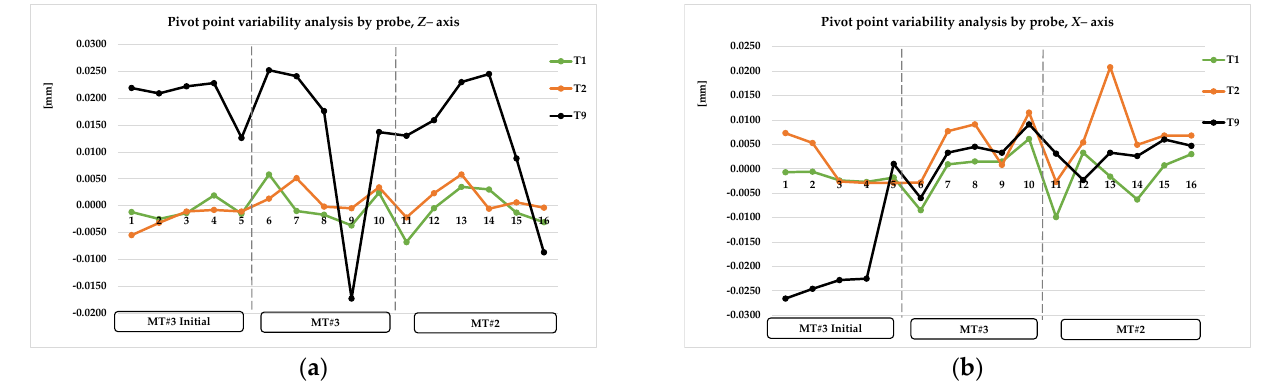
◦ → B 90 ◦ head position;